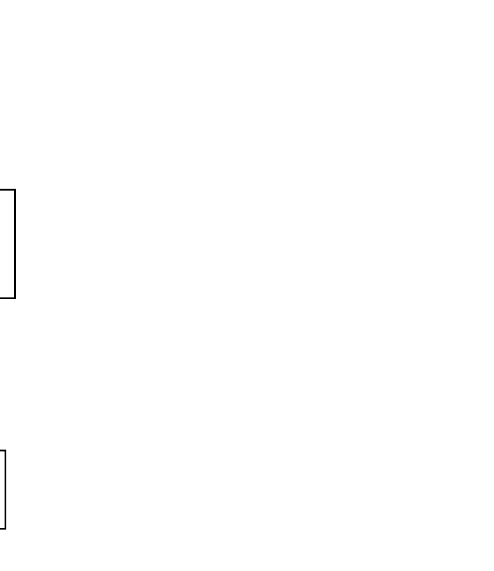
Figure 3. Recurrence rates by category in